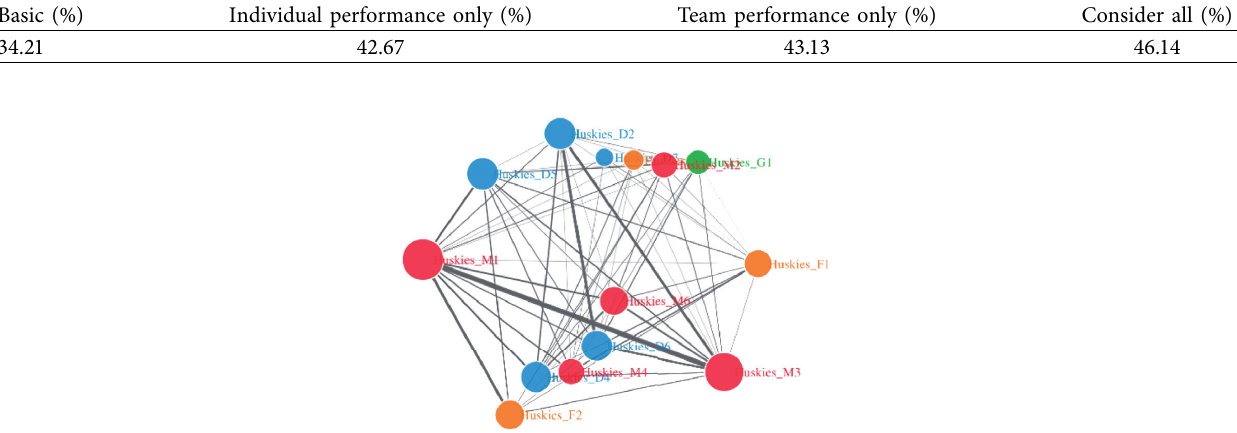
Figure 4: Match 6 huskies’ passing network includes all players.